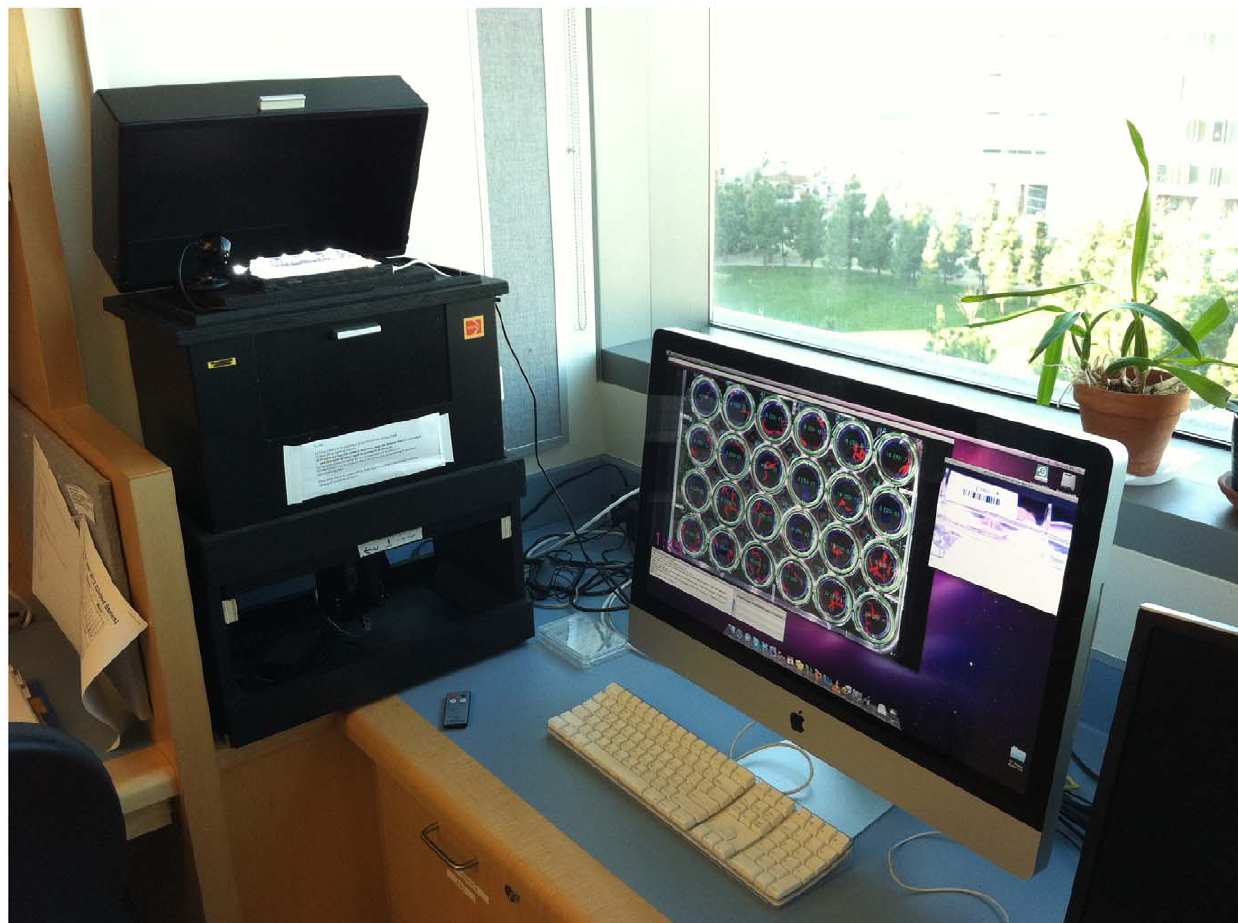
Figure 1. Dark field macroscopic imaging apparatus and computer application. The video camera is positioned below the microtiter plate and the plate is recorded using the WormAssay